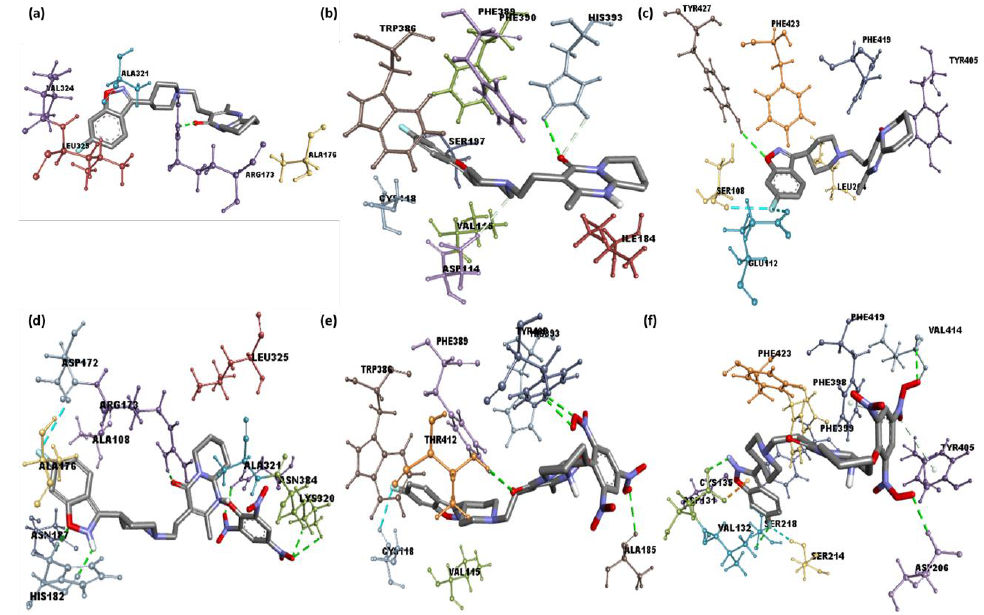
Figure 5. 3D representations of serotonin, dopamine, and adrenergic receptors docked with ( a – c ) risperidone and ( d – f ) CTcS complex.